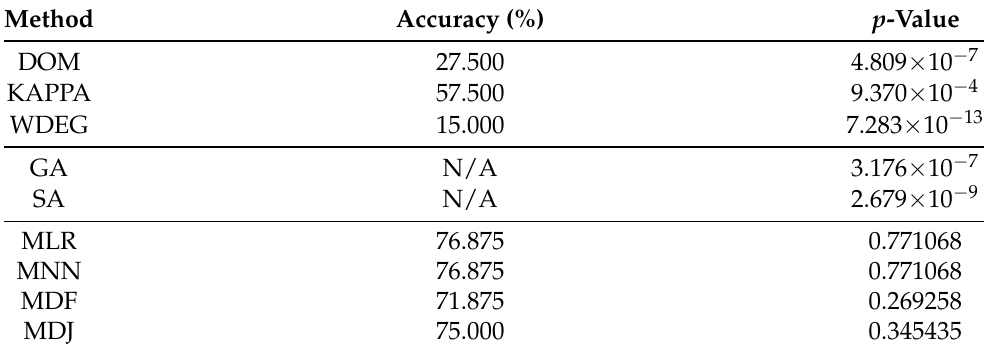
Table 2. Accuracy of the different